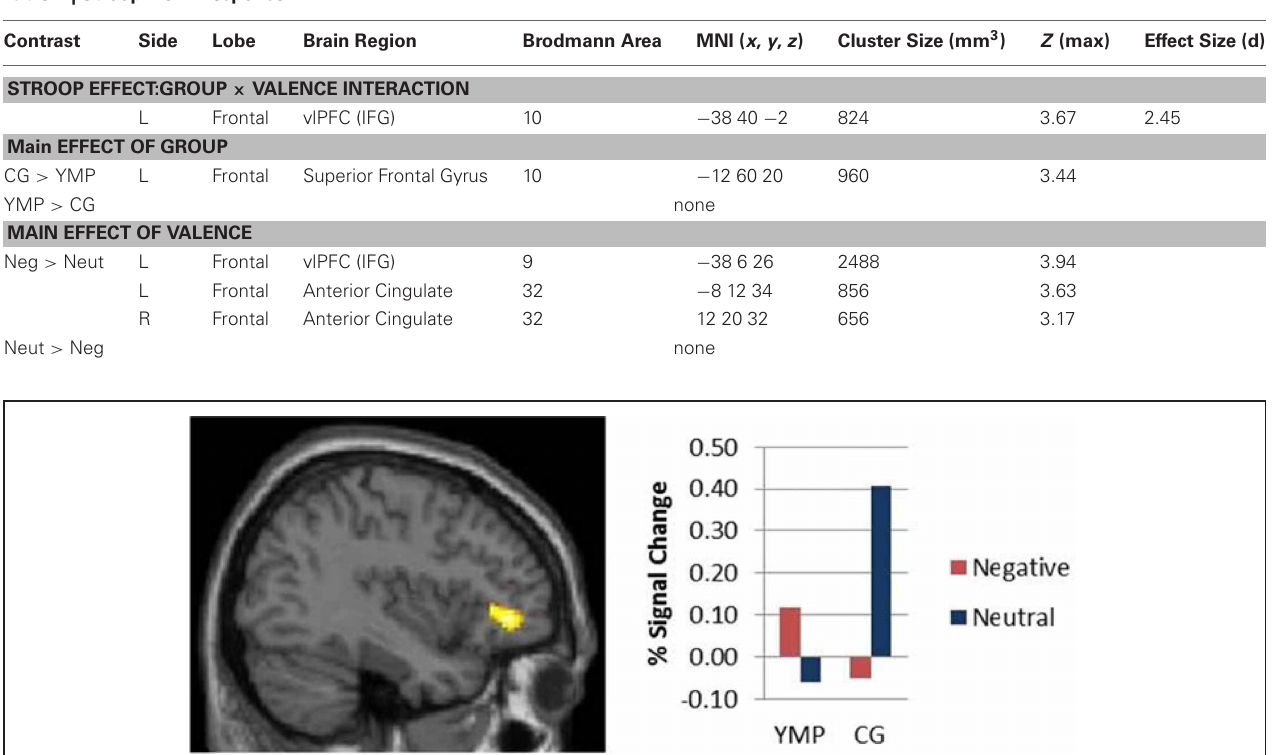
Table 4 | Stroop-BOLD response.